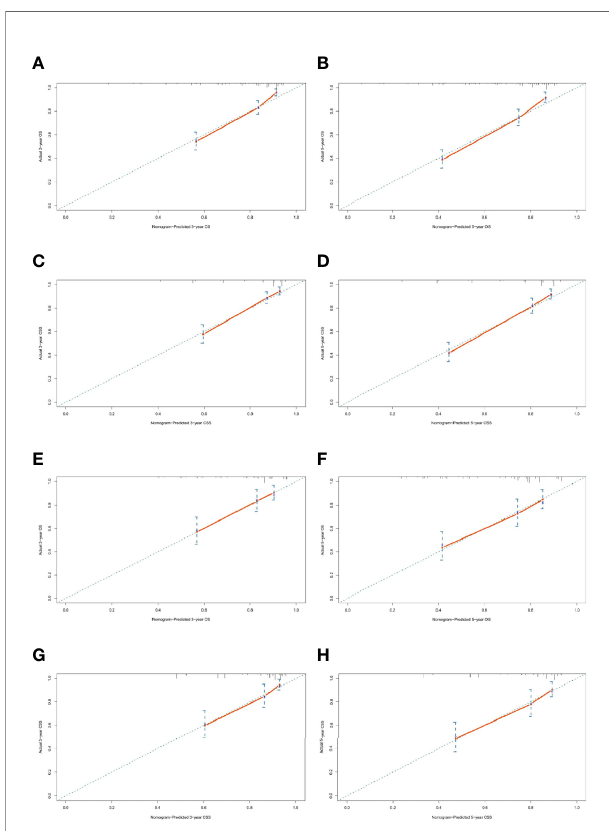
FIGURE 6 | Calibration charts of the nomograms for 3- and 5-year OS and CSS prediction of the training cohort (A – D) and validation cohort (E – H)